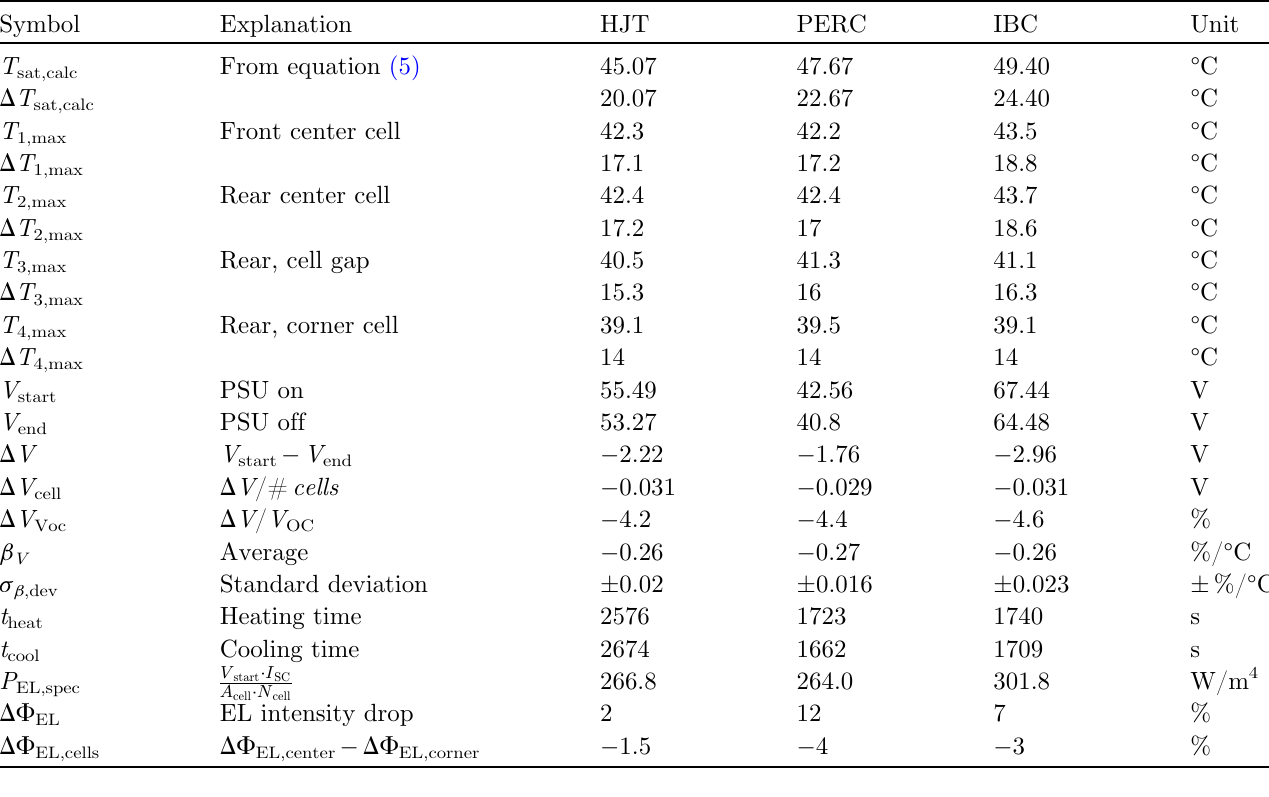
Table 4. Results of the experimental measurements. Symbol